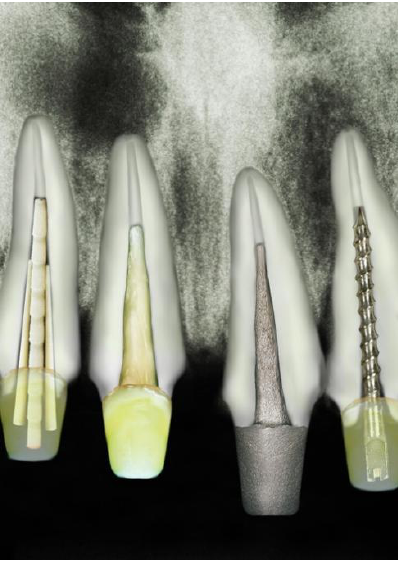
Figure 1. From left to right – Accessory Post, anatomical post, custom metal post, and stainless-steel